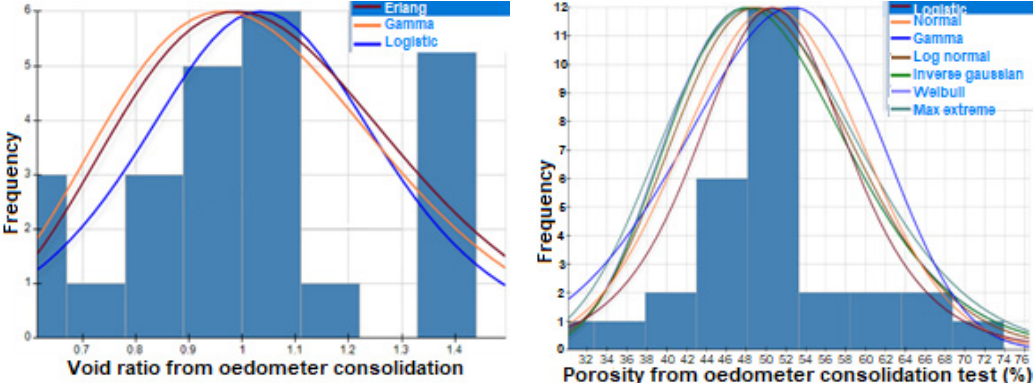
Figure 8. Statistical distributions of void ration and porosity data.